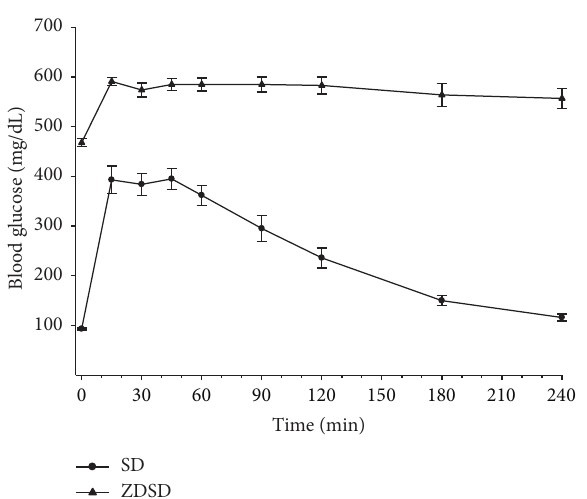
Figure 1: Glucose tolerance in age-matched Sprague Dawley and ZDSD rats. Glucose clearance was determined as described in the Methods section in Sprague Dawley (SD) and ZDSD rats. Data are presented as the mean ± S.E.M. for glucose utilization in mg/dL. The number of rats in each group was 10 and 9, respectively.